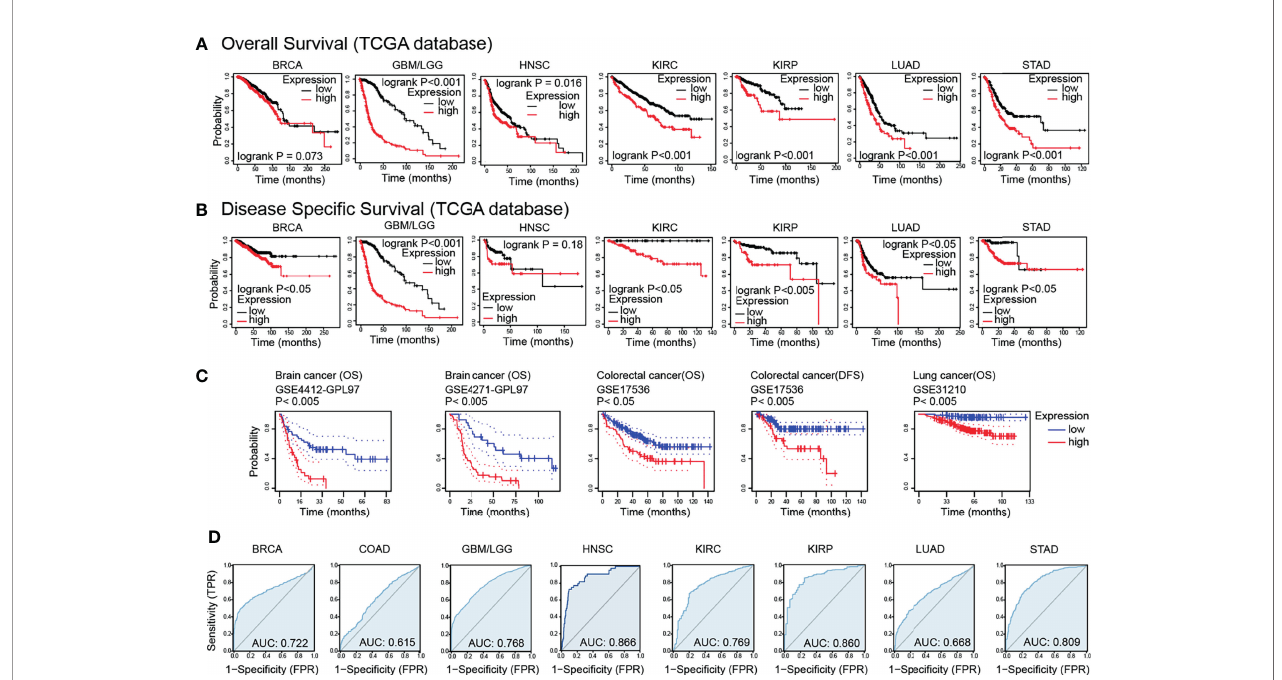
FIGURE 3 | Survival prognosis analysis of cancers. (A) Overall Survival analysis of GPX8 genes in the TCGA dataset. (https://kmplot.com/analysis/). (B) Disease Speci fi c Survival analysis of GPX8 genes in the TCGA dataset. (https://kmplot.com/analysis/). (C) Survival analysis of GPX8 genes in GSE4412-GPL97, GSE4271- GPL97, GSE17536 and GSE31210 (http://dna00.bio.kyutech.ac.jp/PrognoScan/index.html). (D) ROC analysis of GPX8 genes in TCGA